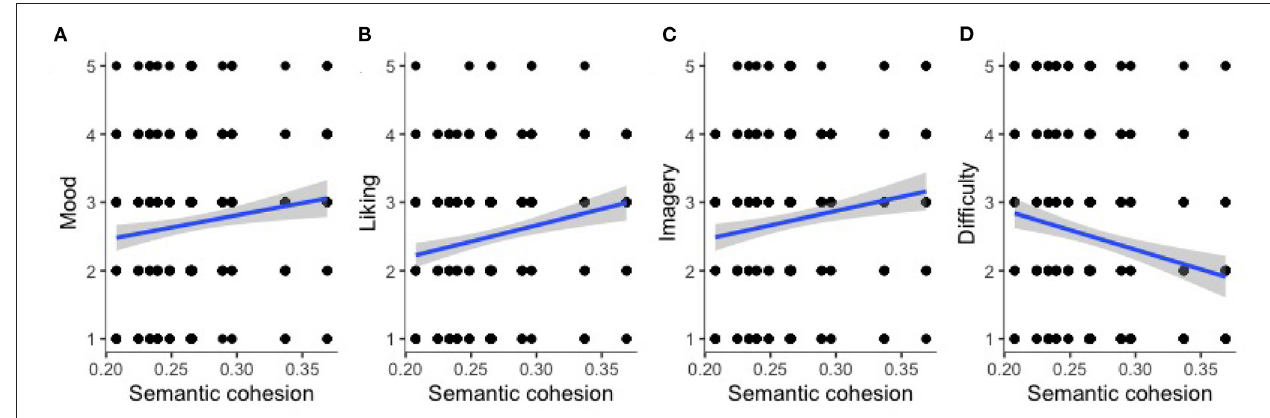
FIGURE 3 | Implicit measures: Relationship between semantic cohesion and participants rating of perceived mood (A) , liking of the items (B) , imagery (C) , and perceived difficulty in understanding (D) .